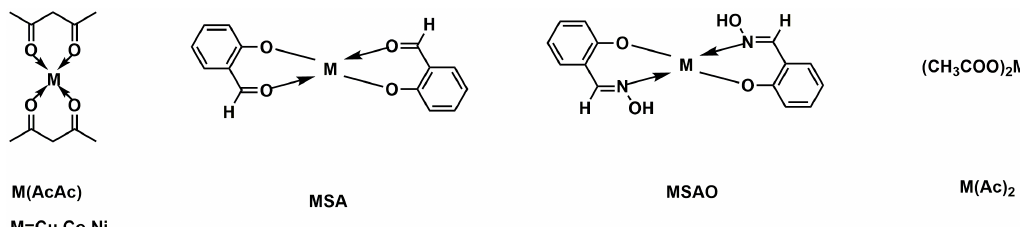
Figure 19. Structure of metal compounds. Readapted with permission from Ref. [183], Copyright 2009, Elsevier Ltd.